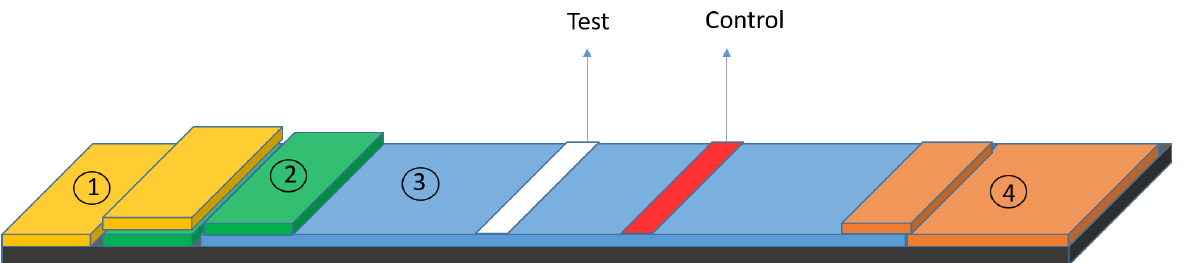
Figure 1. Schematic overview of a lateral flow assay (LFA) device showing the four components and the test and control lines for readout of the result.